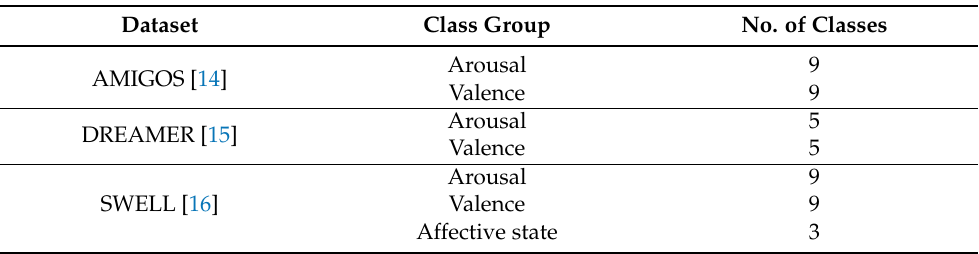
Table 4. Summary of the datasets with their respective characteristics such as the number of classes and